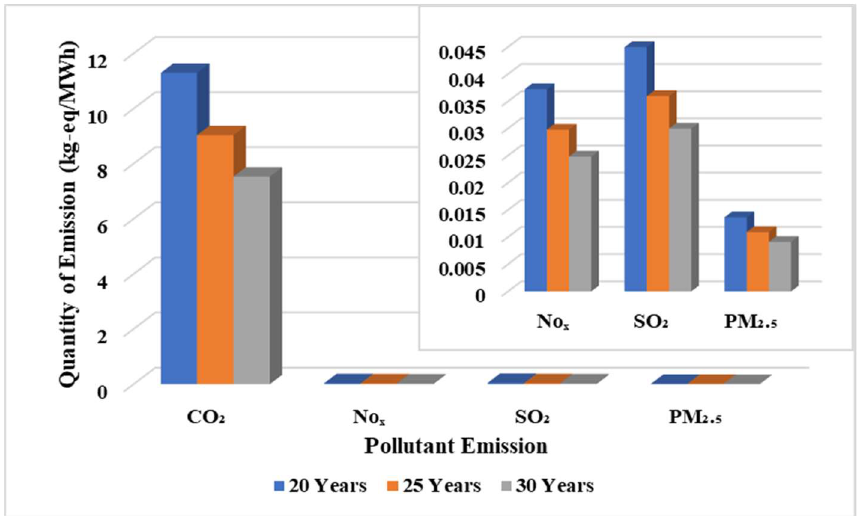
Figure 7. Pollutant emissions at the different life cycles of the wind farm.